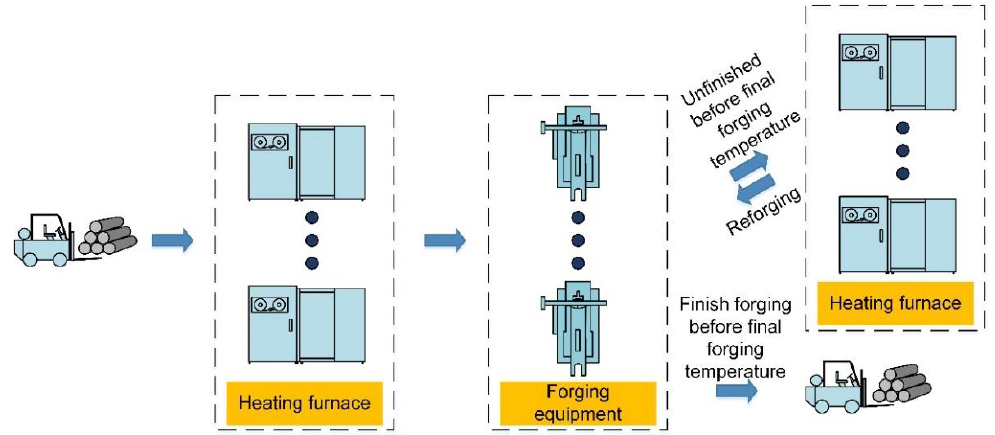
Figure 5. Forging workshop production process.